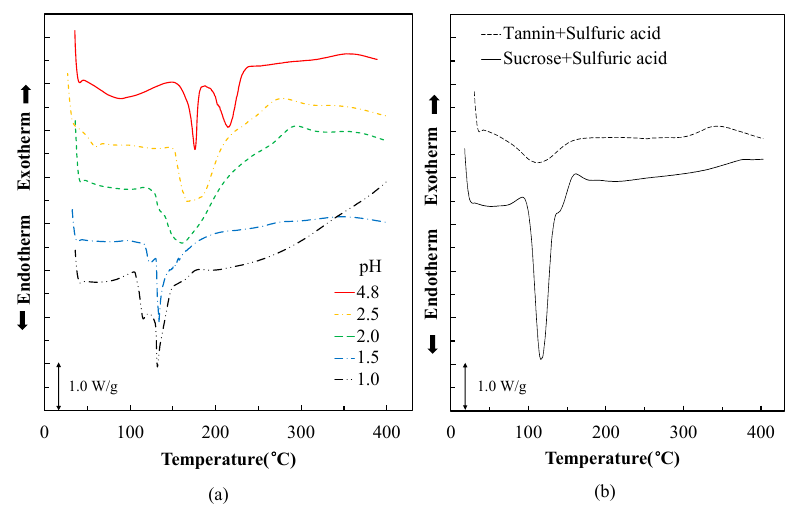
Figure 2. Differential scanning calorimetry (DSC) curves of the mixtures. ( a ) TG curves of tannin–sucrose–sulfuric acid mixture with different pH; ( b ) TG curves of tannin–sulfuric acid and sucrose–sulfuric acid mixture at pH = 1.0.